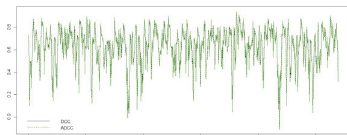
Fig. 9. Dynamic Conditional Correla- tion at D1 Scale